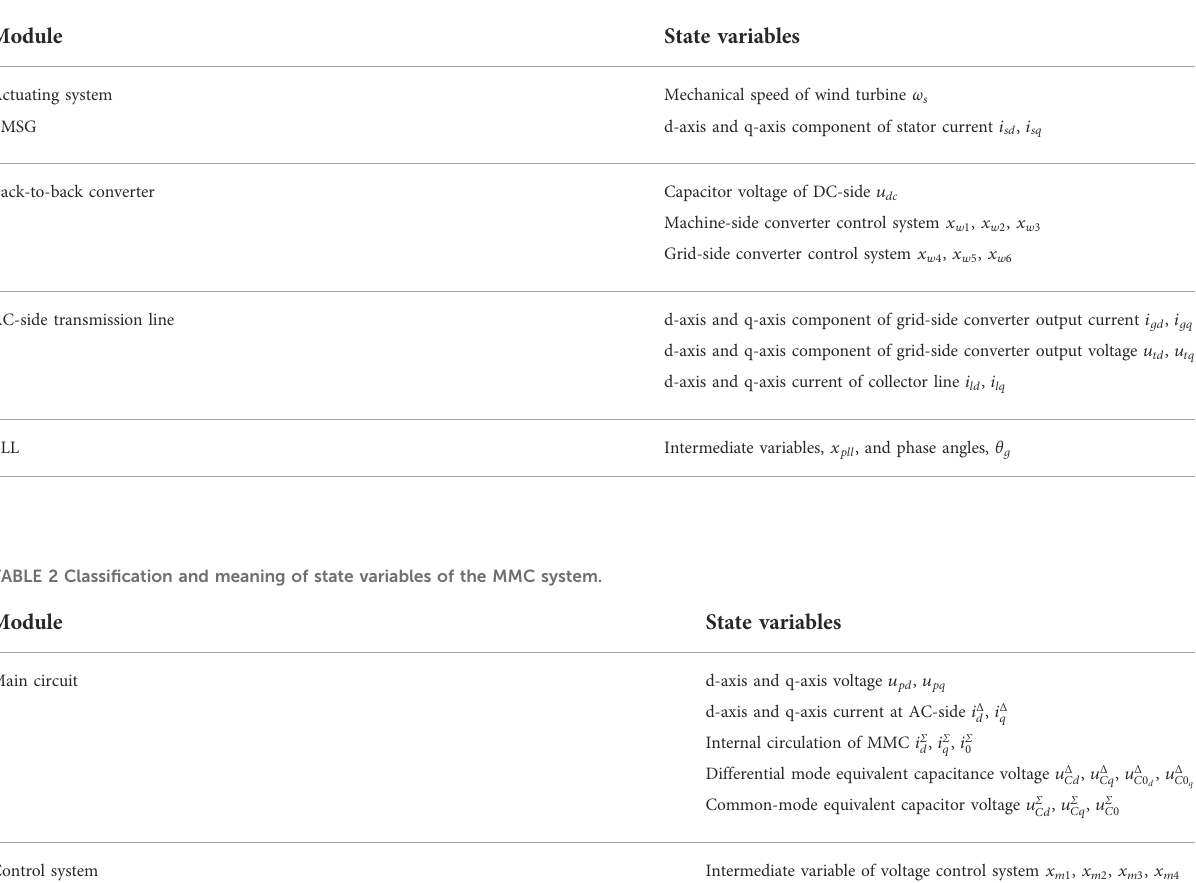
Table 1. At the same time, the state variables are classi fi ed according to each module of the MMC system, and the classi fi cation results are shown in Table 2.